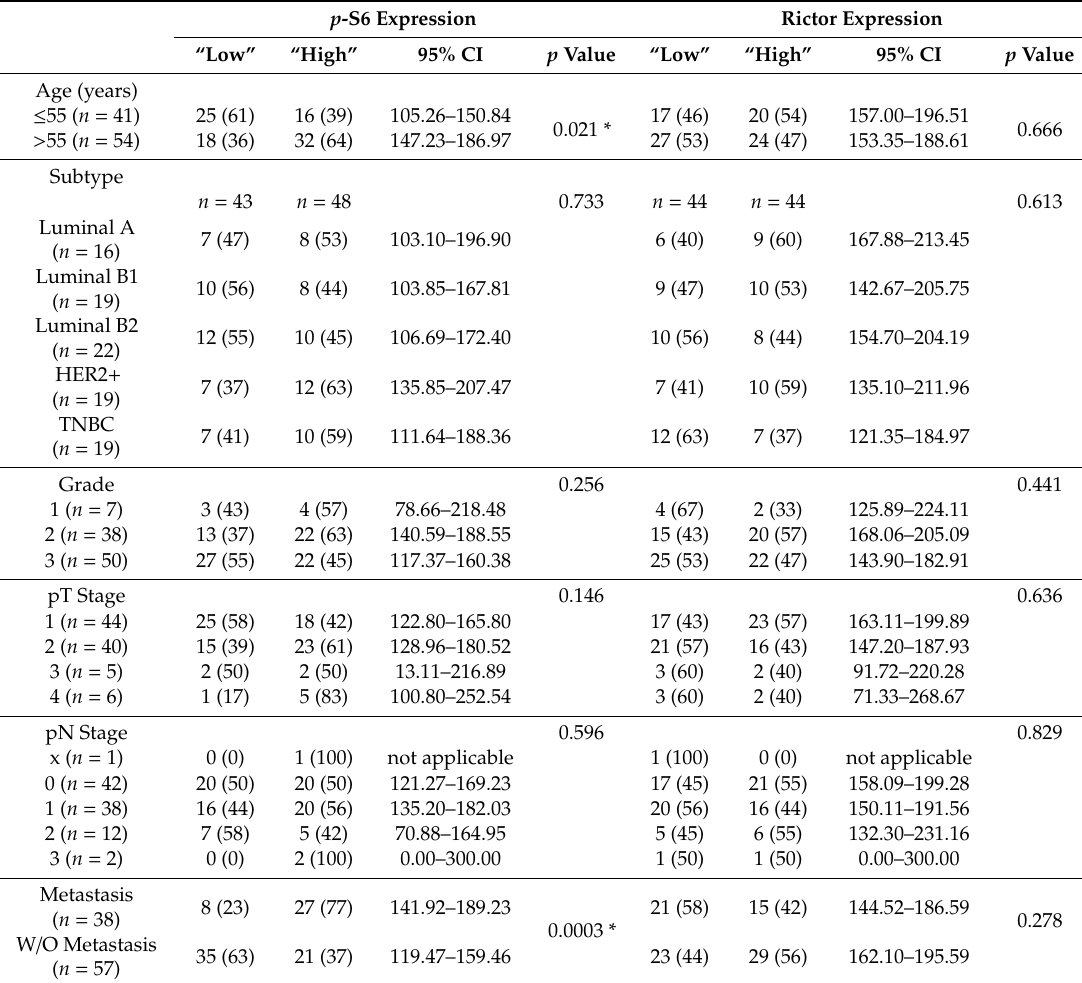
Table 1. Correlation of clinicopathological parameters of breast cancer patients with selected markers of mTOR complexes (determined by IHC). * p <